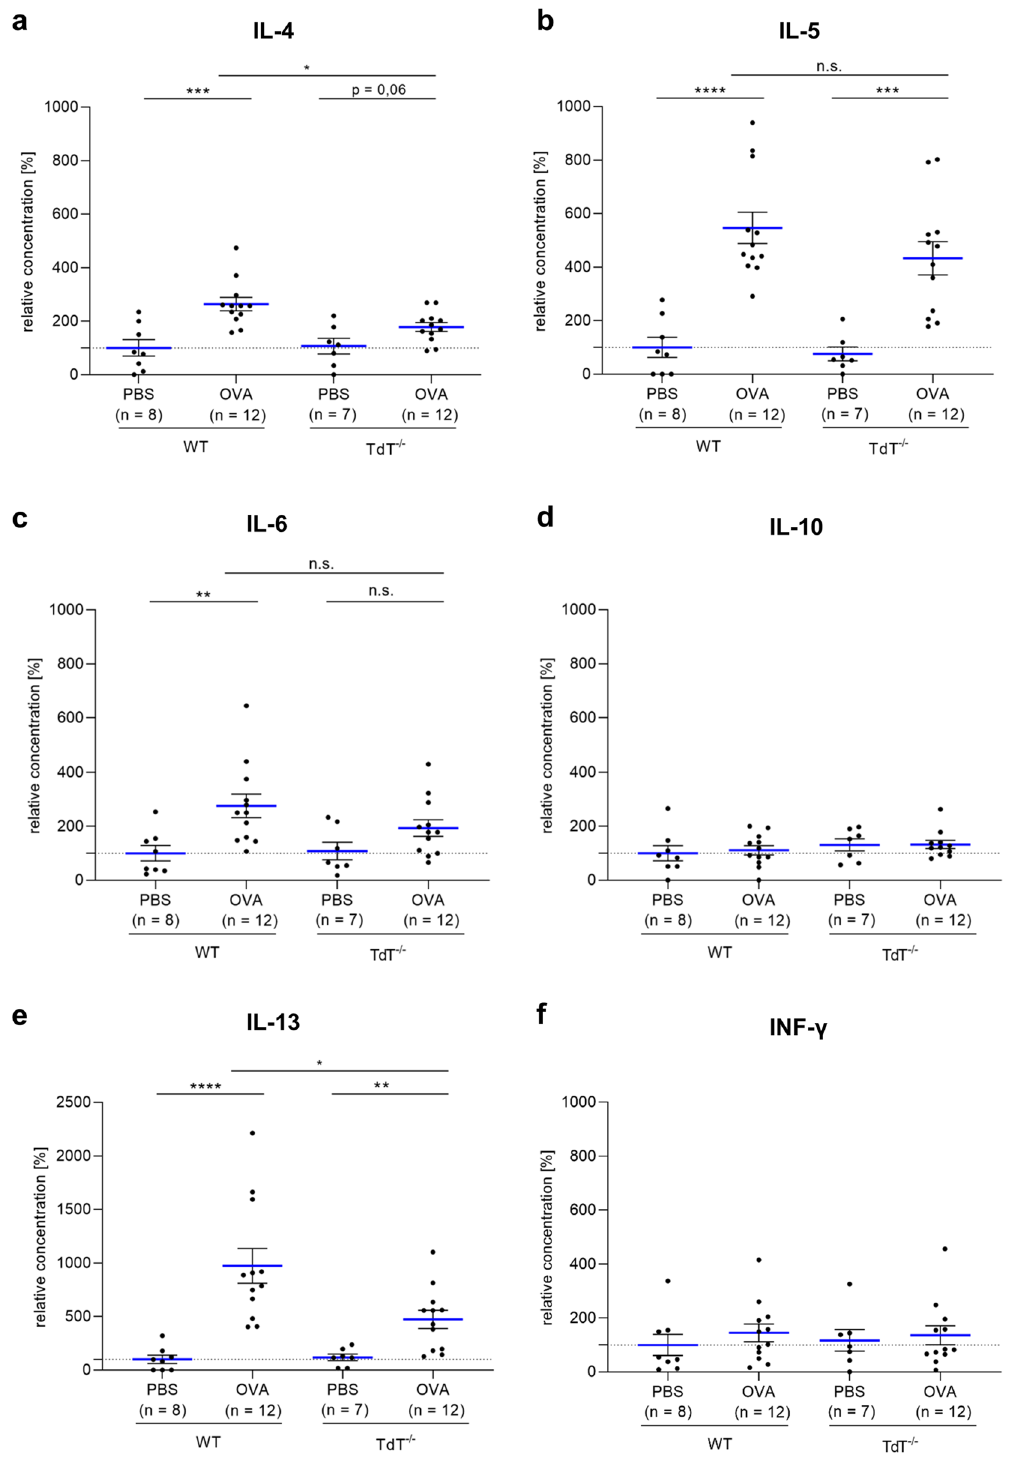
Figure 2. Cytokine level in BAL fluids. In BAL fluids of wt and TdT −/− mice, both sensitized and non-sensitized, cytokine levels of ( a ) IL-4, ( b ) IL-5, ( c ) IL-6 ( d ) IL-10 ( e ) IL-13 and ( f ) INF-γ were measured using Cytokine Multiplex Assay. ( a – c ) Sensitization with OVA resulted in a marked increase in cytokine levels of IL-4 in TdT −/− (p = 0.06) compared to non-sensitized mice. A significant rise was observed in IL-4 levels in wt (p < 0.001), in IL-13 ( Wt p < 0.0001; TdT −/− p < 0.01) and IL-5 ( Wt p < 0.0001; TdT −/− p < 0.001) compared to non-sensitized mice. However, this increase was attenuated in sensitized TdT −/− mice compared to wt mice (p < 0.05 (IL13 and IL-4)). ( d – f ) The levels of the cytokines IL-6, IL-10 and INF-γ showed no differences between the two genotypes. All levels were normalized to wt control (mean shown as blue lines, SEM shown as black